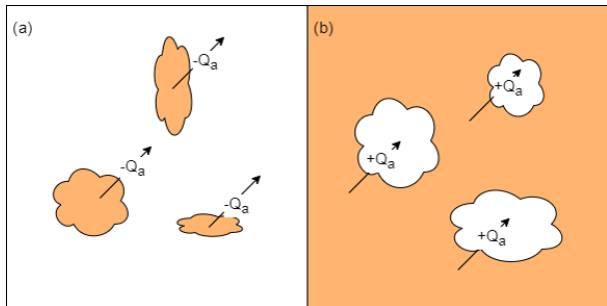
Figure 2. Conceptual model of advection dynamics for (a) the early melt period where energy is limited to what is transported out of soil (brown) patches to the surrounding snow (white), and for (b) the later melt period where snow patches remain and advection energy is limited to that exchanged over the discrete